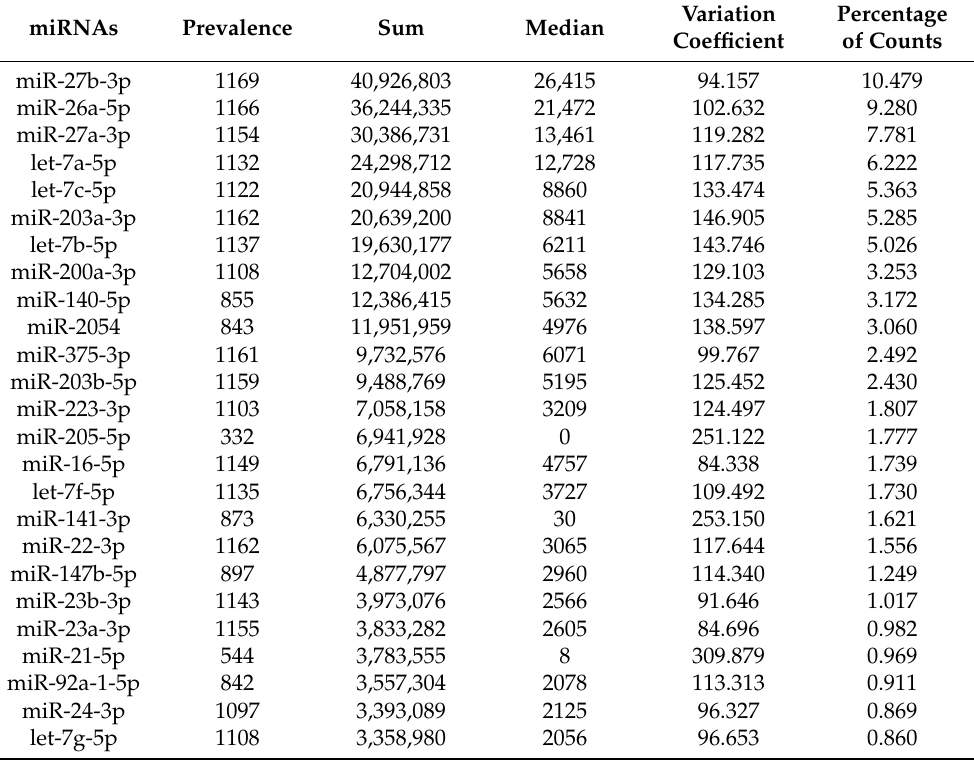
Table 3. Twenty five miRNAs account for over 80% of all read counts across 1225 saliva